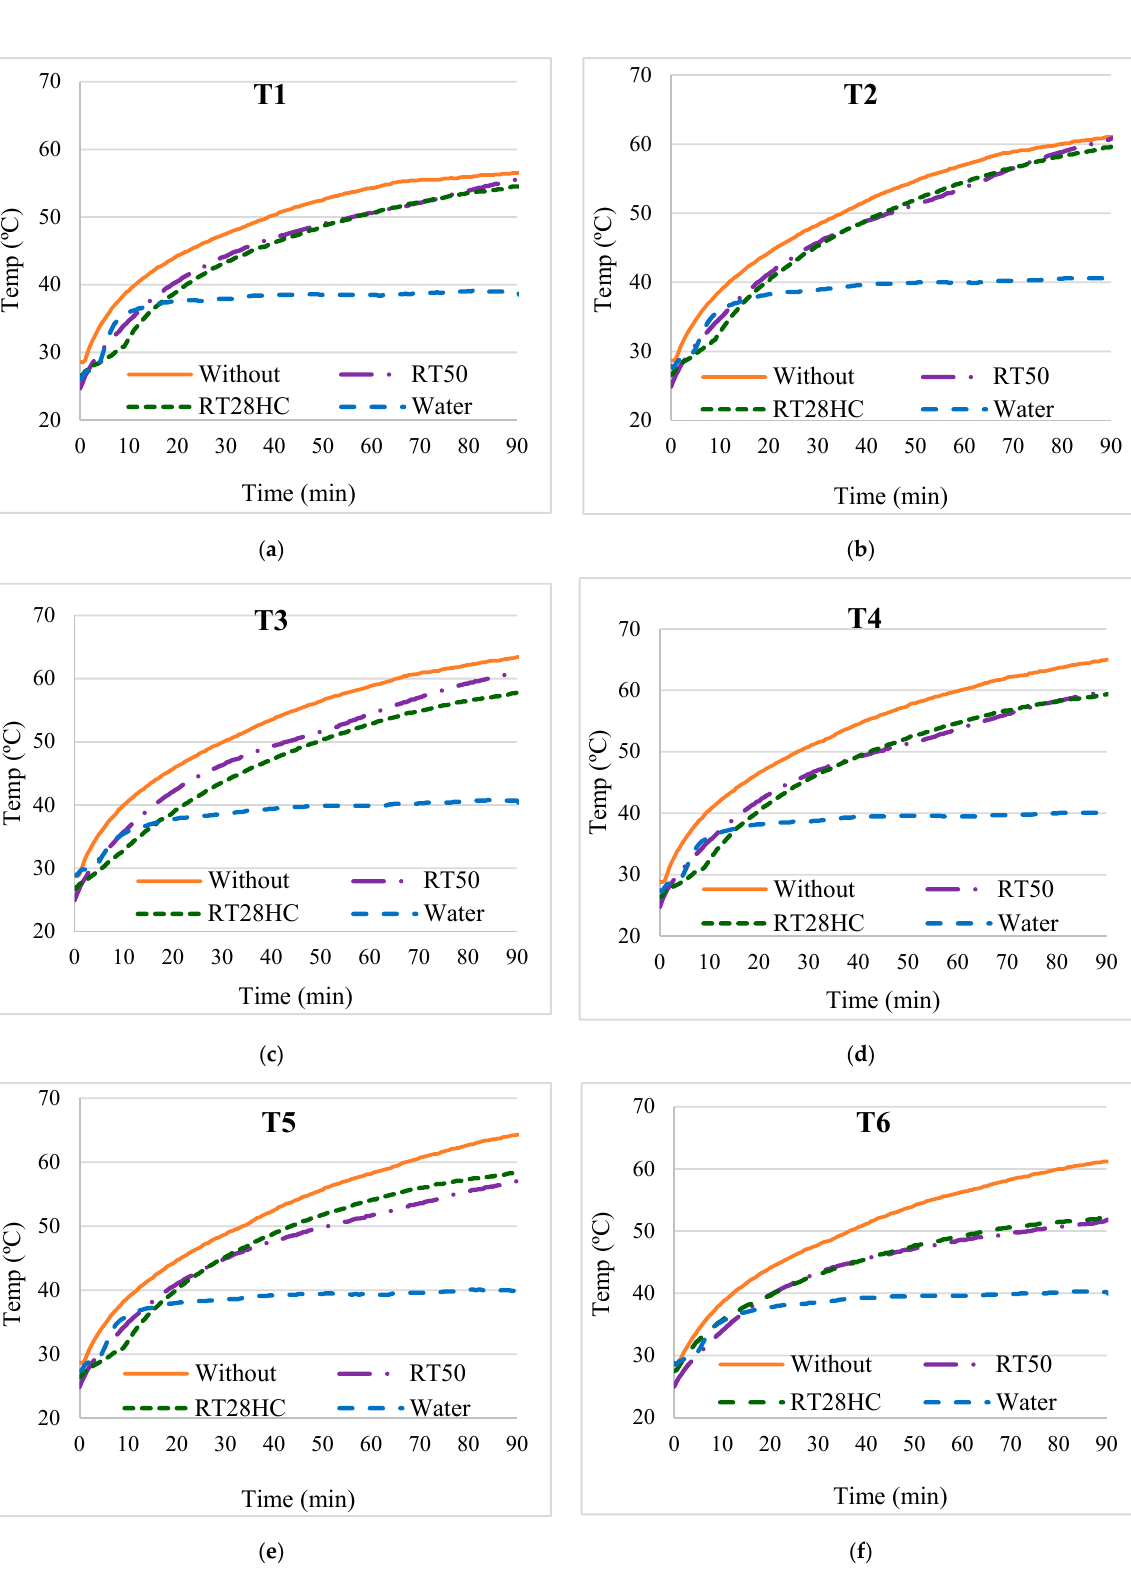
Figure 6. Comparison of individual channel temperature profiles ( a ) T1 (channel on the edge of the panel experiencing maximum natural convection), ( b ) T2, ( c ) T3 (one of the centrally located channels), ( d ) T4 (another central channel), ( e ) T5, and ( f ) T6 (location of channels can be referred to from Figure 1).